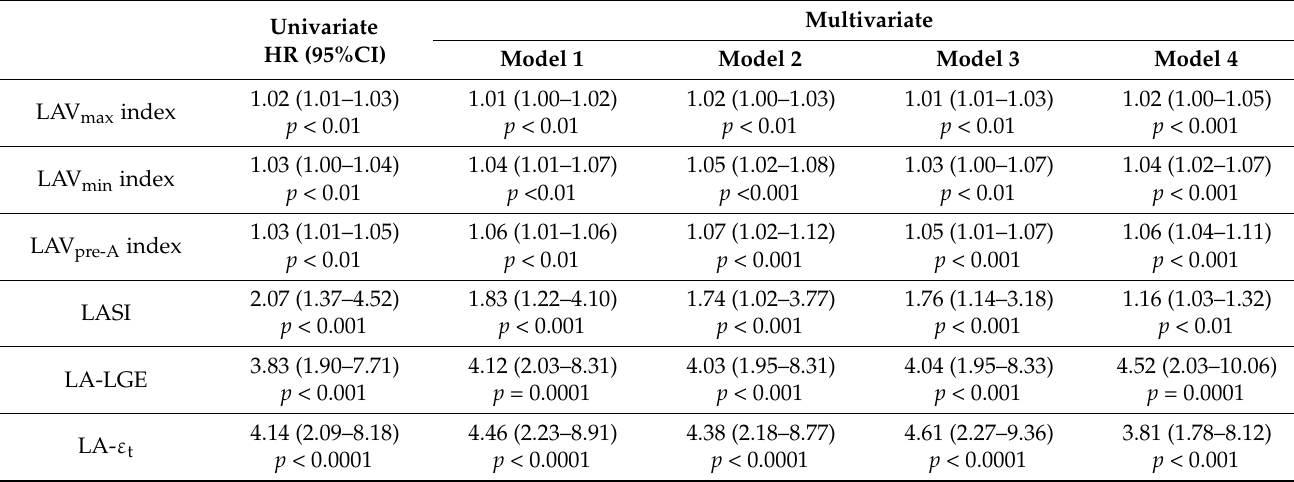
Table 5. Univariable and Multivariable Cox Regression Analyses: Association of left atrial functional indices with the composite end